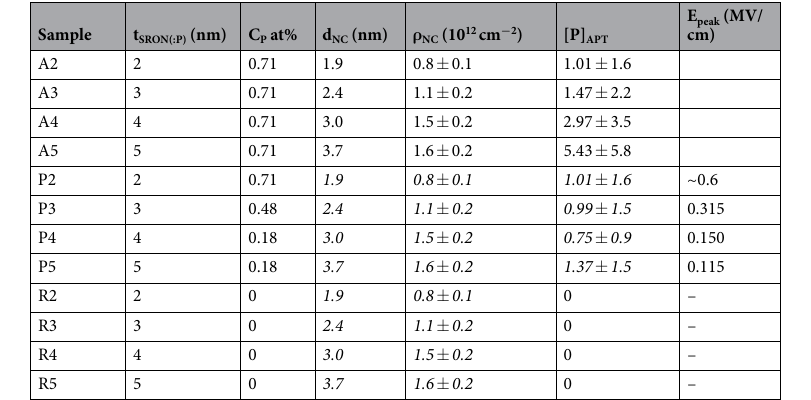
Table 1. Data values of the structural and electrical characterization. Here, t SRON(:P) denotes the Si-rich oxide layer thickness, C P the nominal P-concentration in SRON:P, d NC the mean NC size, ρ NC the areal density of NCs per cm² and SL layer, [P] APT the average number of P-atoms per NC, and E peak the electric field of the J-peak in Fig. 3a. Extrapolated values are in italic